Question: Provide a publication-style caption for this figure.
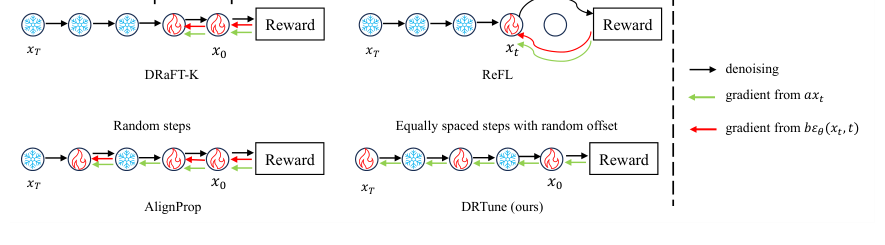
Answer: Comparison between reward training algorithms.